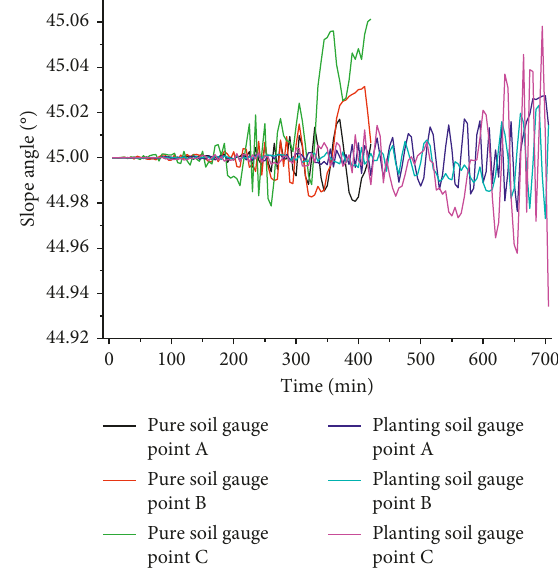
Figure 11: Changes in the slope angle.